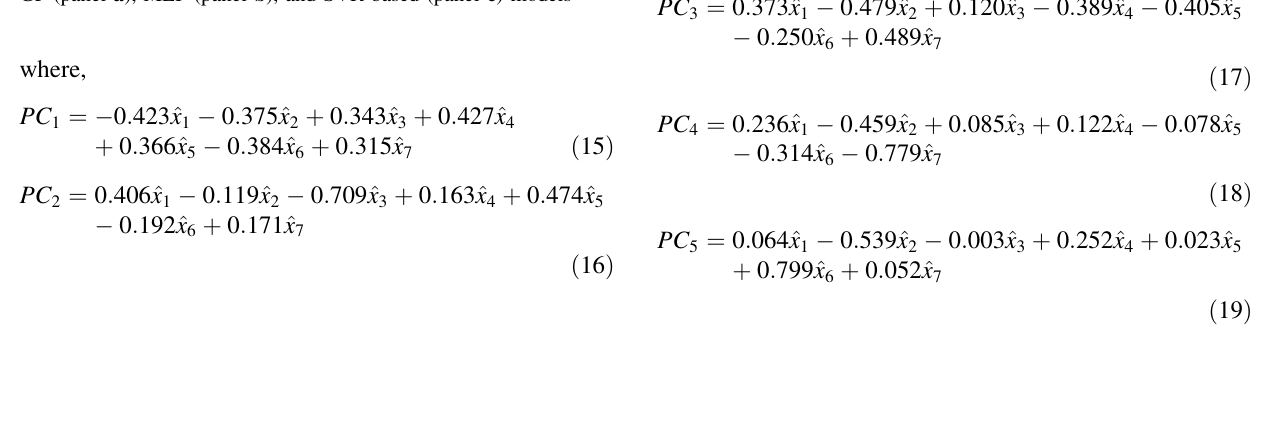
Fig. 9 Plots of experimental ST values versus those predicted by the GP (panel a ), MLP (panel b ), and SVR based (panel c ) models